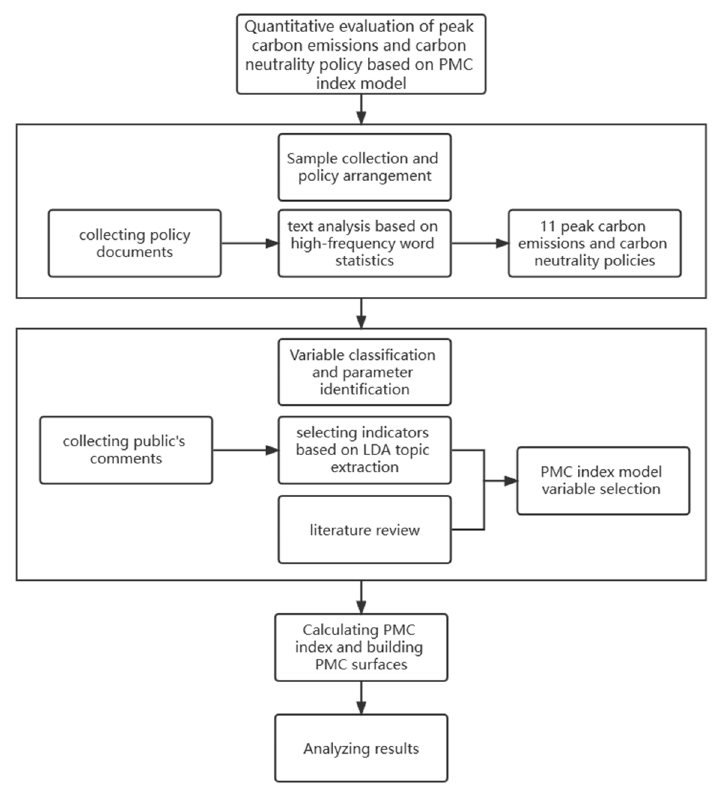
Figure 1. The research